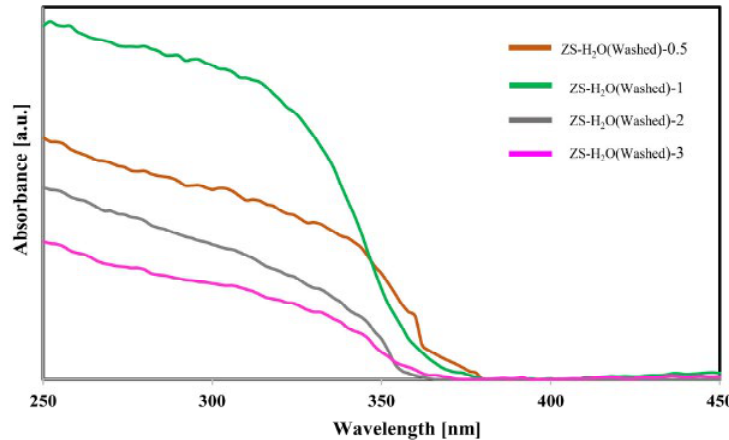
Fig. 9. Diffuse reflectance spectra of synthesized samples using different values of CTAB Figure 9 . Diffuse reflectance spectra of the synthesized samples using different values of CTAB CMC.